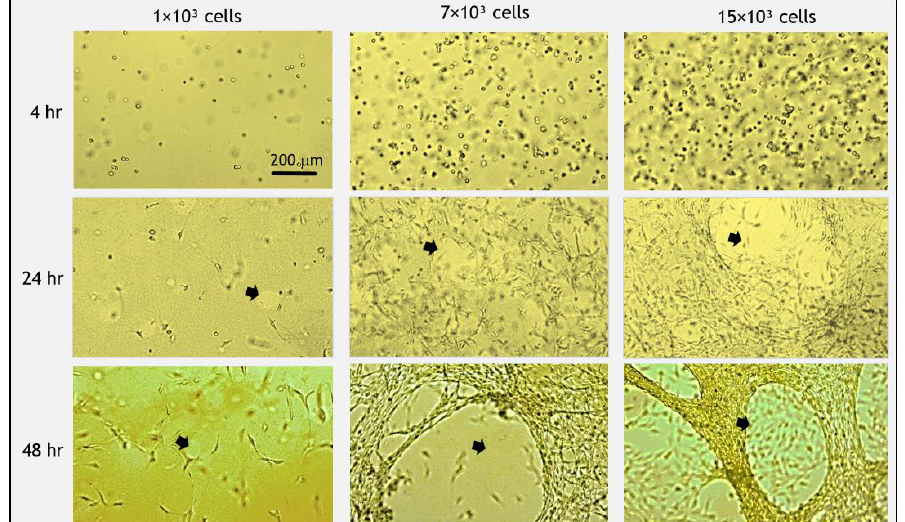
Figure 3. Morphology of fibroblast cells embedded in fibrin gels and gel degradation over time. Initially (<4 h post-seeding), cells were round and then spread out and elongated. At 48 h post- seeding, all cells took on a spread morphology. Degradation of the gel was apparent after 24 h, which accelerated at 48 h (arrows indicate holes of degradation). At higher cell concentrations, more gel degradation occurred. Scale bar is 200 µm.